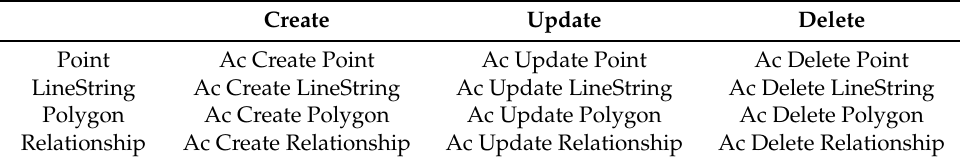
Table 3. Create, update and delete action types for each geometry